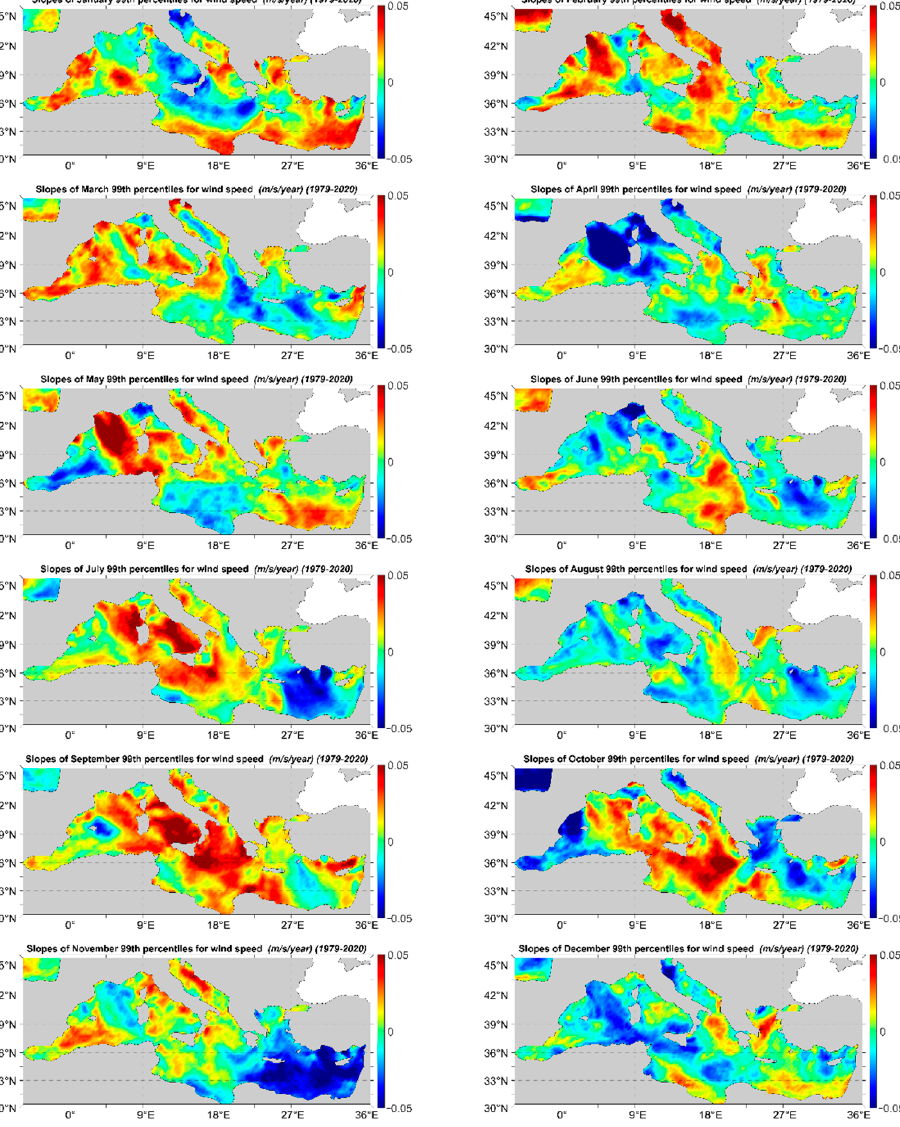
Figure 17. Linear slopes of the monthly 99th percentile of wind